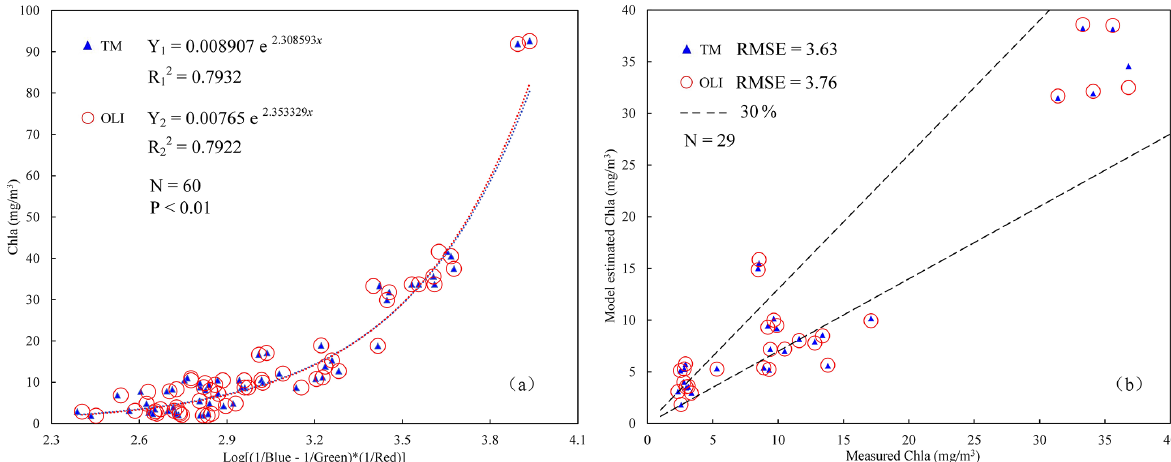
Figure 3. The calibration (a) and validation (b) results of the Chl a retrieval models based on 89 in situ data for Landsat sensors.